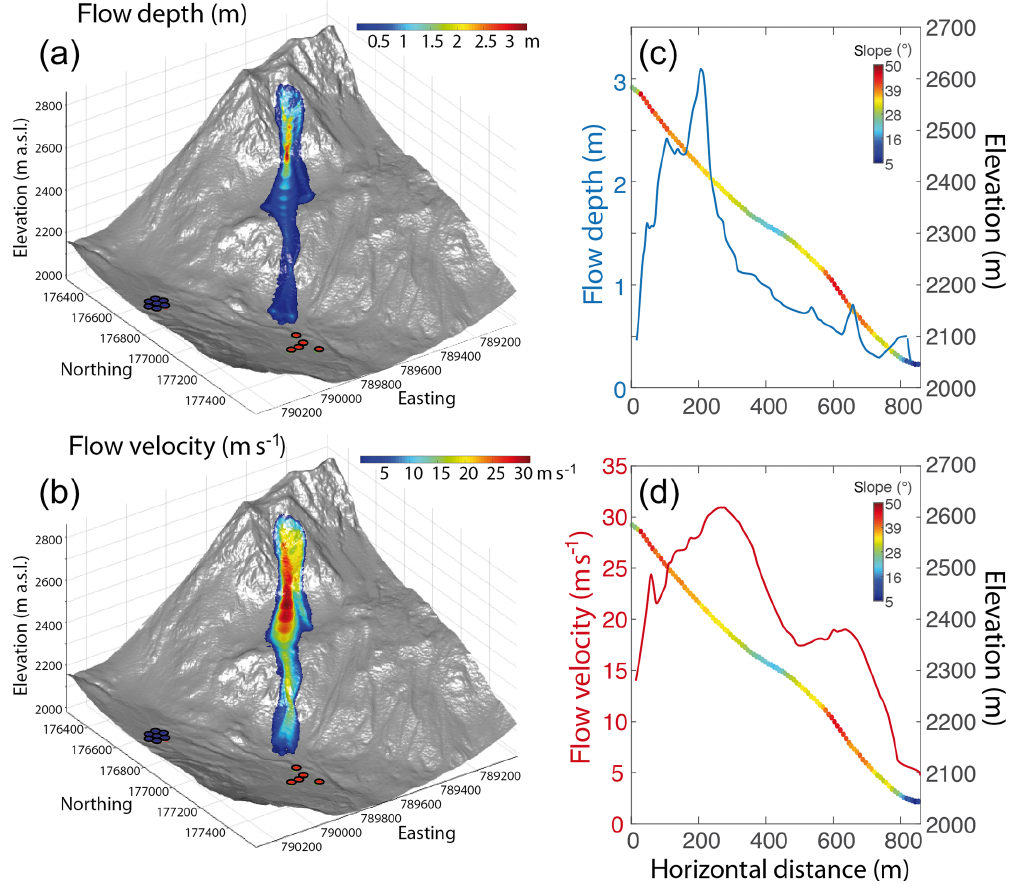
Figure 8. Figure showing the flow extent modelled by RAMMS and highlighting maximum flow depth (a) and flow velocity (b) . Profiles of the modelled flow depth (c) and flow velocity (d) along the path imposed on the avalanche path profile (colour coded according to its slope) as a function of the travelled horizontal distance are